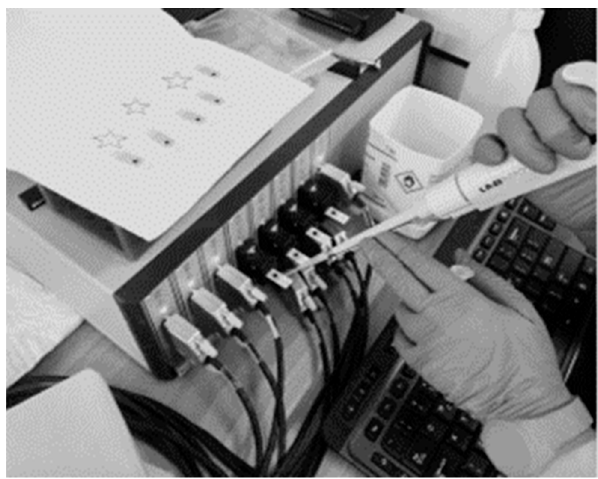
Figure 2. The cyclic voltammetric version of the biosensor, allowing for measurements of up to eight channels synchronously or independently. Stars indicate a group of disposable screen-printed